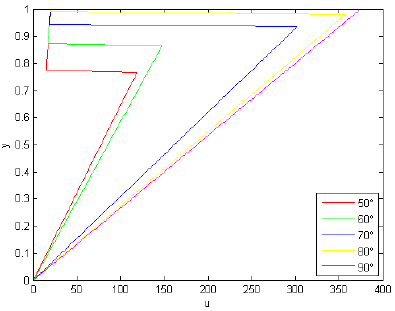
Figure 6. The asymptotic solution U +( 0 ) of the Stoke–Brinkman equations.